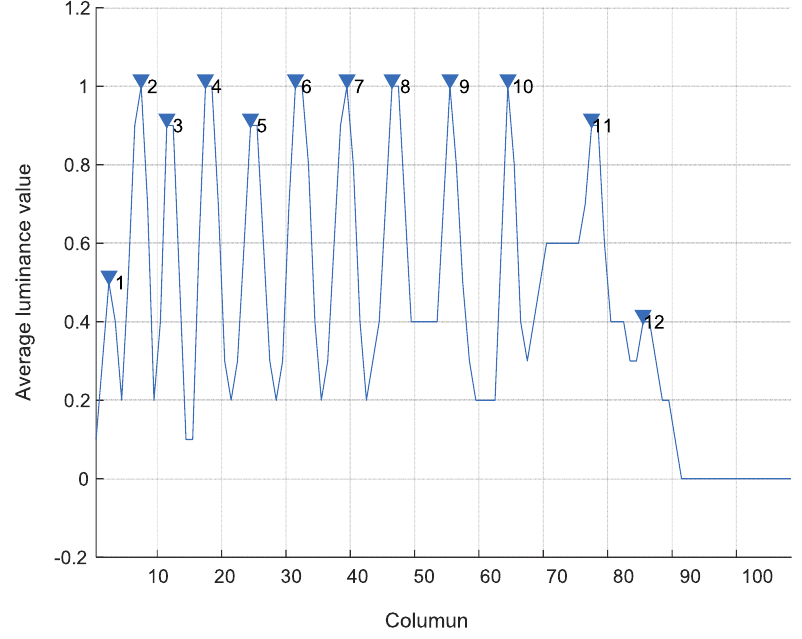
Figure 10. Histogram. The horizontal axis represents the image’s columns and the vertical axis shows the average luminance per column. Triangles indicate the ordinal number of each